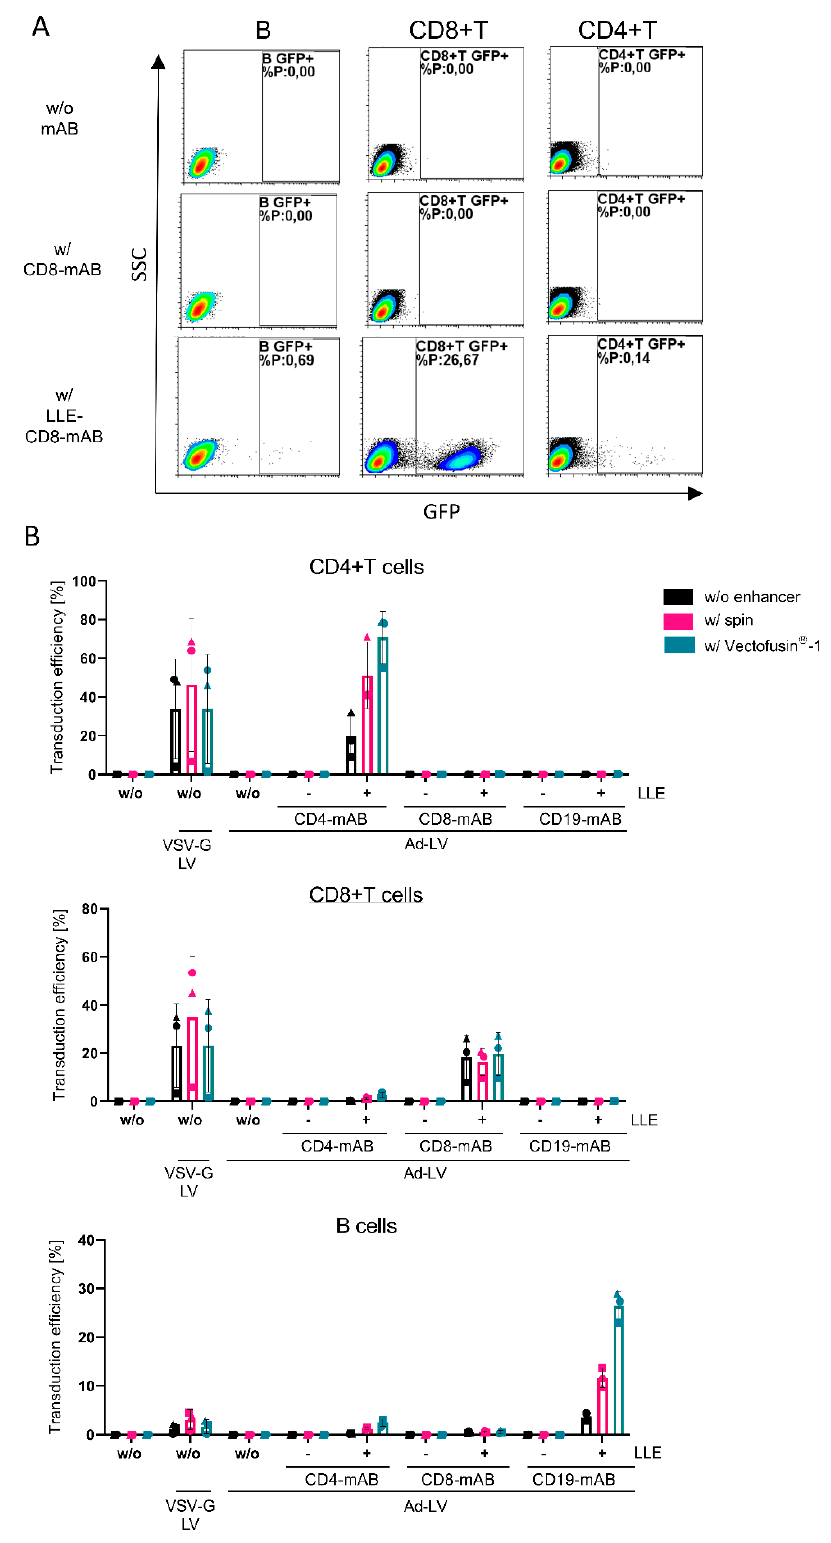
Figure 5. Selective transduction of human T and B cells within activated PBMCs using different transduction protocols. Activated PBMCs were transduced with Ad-LVs with 0.1 TU/cell in the absence of adapter (w/o) and in the presence of CD4-mAB (clone:MT-466, 100 ng/mL), CD8-mAB (clone: BW135/80, 10 ng/mL), or CD19-mAB (clone: LT19, 100 ng/mL) with (+) or without LLE-tag (- ). ( A ) Representative data are shown using LLE-CD8 mAB or CD8-mAB w/o enhancer. ( B ) Three transduction conditions were compared: using no enhancers, using spinoculation, or the